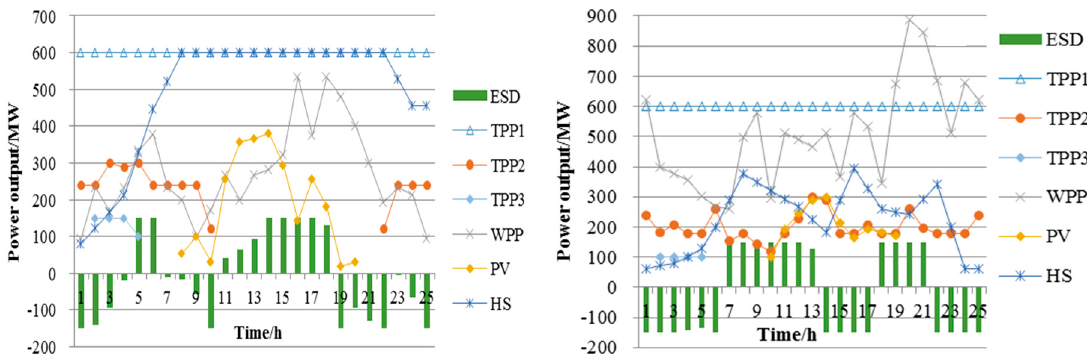
Figure 9. The MECS scheduling results on typical days under the OEE mode: summer ( left ) and winter ( right ).